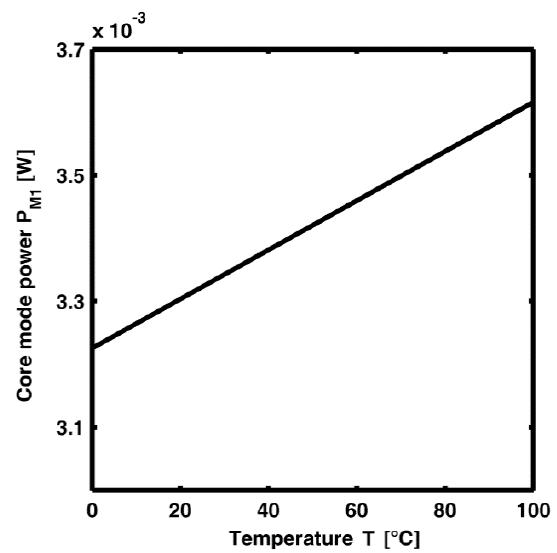
Figure 6. Power of the fundamental core mode M 1 at the pump wavelength versus the temperature, at the output section of CLPG 1 when each LPG is optimized separately.